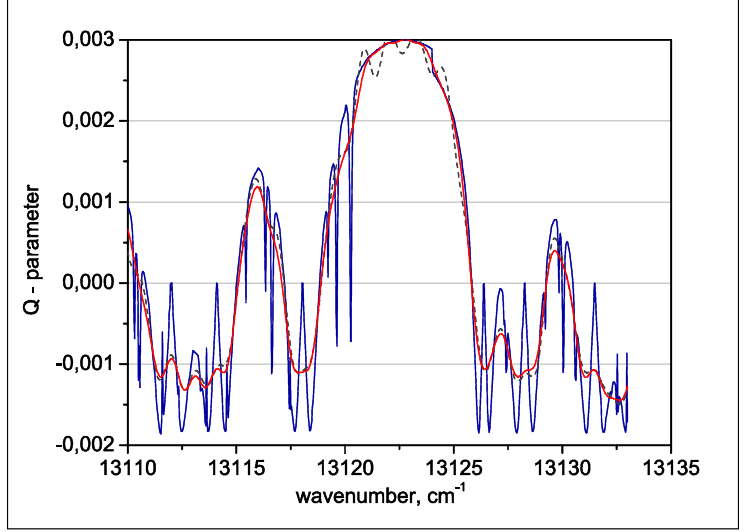
Figure 11. Initial (blue line) and convoluted with the response function (Figure 1) (red and gray lines) spectra of the normalized Q -parameter in the standard ―Mid-latitude Summer Atmosphere‖. The homogeneous aerosol layer is between 0–1 km. Solid blue line—initial spectrum; red solid line and dashed gray lines—convoluted spectra obtained by the second method using 2 × 10 6 and first method using 2 × 10 4 photons,